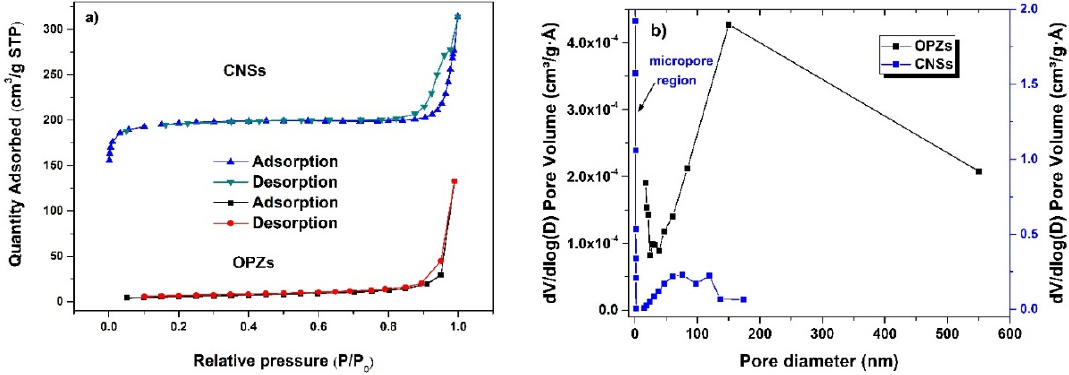
Figure 3. ( a ) N 2 adsorption ‐ desorption isotherms; and ( b ) pore size distribution of the OPZs and CNSs.